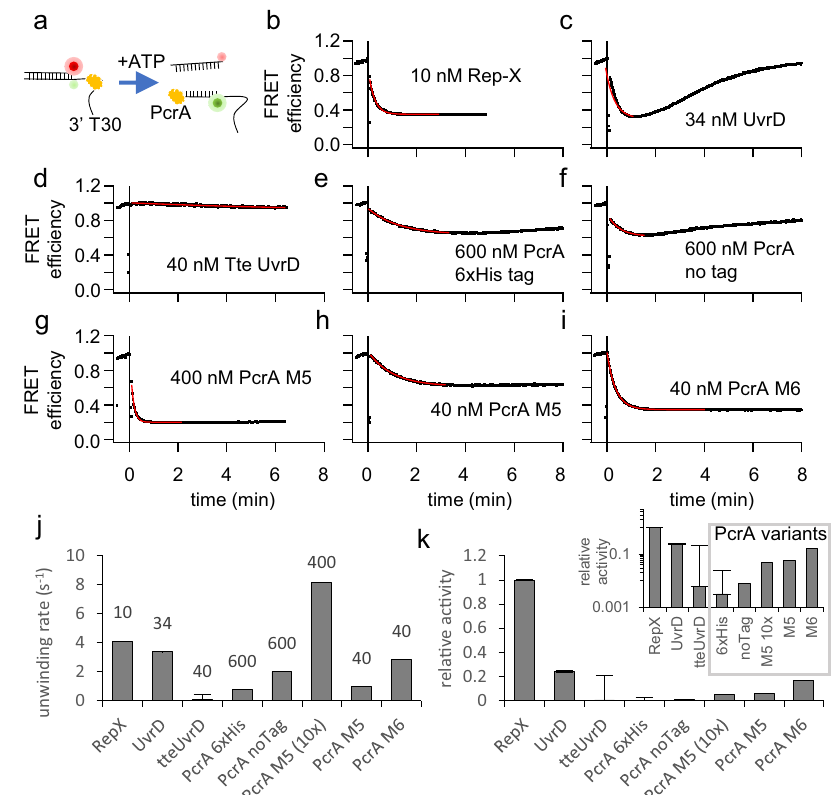
Fig.6|BulkunwindingactivityofdifferentDNAhelicasesat37°C. Eachhelicase is at different concentration, while all other conditions are fi xed. a Unwinding reaction of FRET-pair labelled DNA construct. b Rep-X superhelicase shows the highest unwinding activity even at a low concentration of 10nM. c E. coli UvrD helicase at34nM shows highinitialunwinding activity,butthereactionterminates quickly resulting in the DNA reannealing likely due to ATP depletion. d Thermostable Tte UvrD helicase at 40nM shows very low unwinding activity at 37°C. e Wild-type PcrA expressed with 6xHis tag shows low unwinding activity at 600nM. f Wild-type PcrA without 6xHis tag shows low unwinding activity at